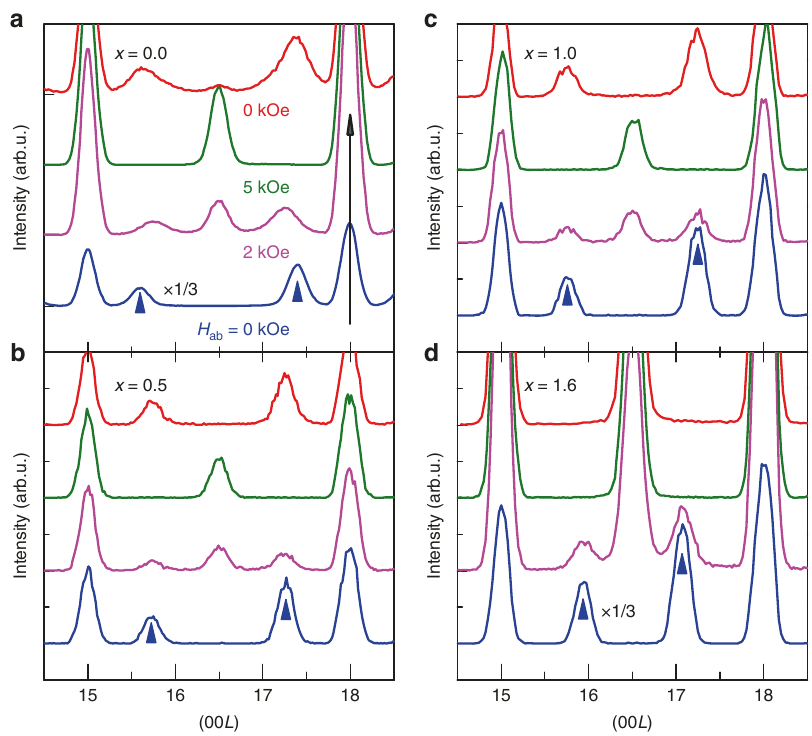
Fig. 4 Neutron diffraction of Ba 2- x Sr x Mg 2 Fe 12 O 22 at 1.5 K. Neutron diffraction (0 0 L ) scan pro fi les under different H ab for a x = 0.0, b x = 0.5, c x = 1.0 and d x = 1.6 samples. All the samples initially experienced zero- fi eld cooling down to 1.5 K. Then the magnetic fi eld was changed in the order 0 kOe → 2 kOe → 5 kOe → 0 kOe. (0 0 15) and (0 0 18) peaks are the nuclear diffraction peaks and L = 3( n ± δ ) denote magnetic diffraction peaks. The arrows indicate magnetic diffraction peaks (0 0 3n ± 3 δ 0 ) after initial zero- fi eld cooling